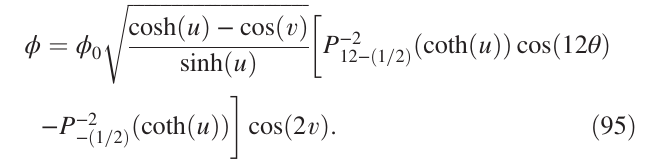
FIG. 4. Magnetic field in a curvilinear skew sextupole, derived from the scalar potential (92). Top left: B x ¼ 10 mm and y ¼ 0 . Top right: B as a function of x for y ¼ 0 and s ¼ π x ρ . In each plot, the field is scaled by the beam Bottom right: B along the line x ¼ y , for s ¼ π 12 y